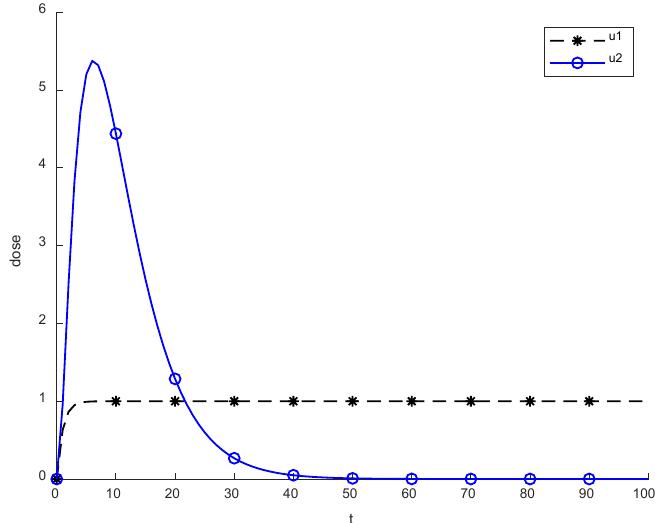
Figure 2. Behavior of constant and continuous chemotherapy.